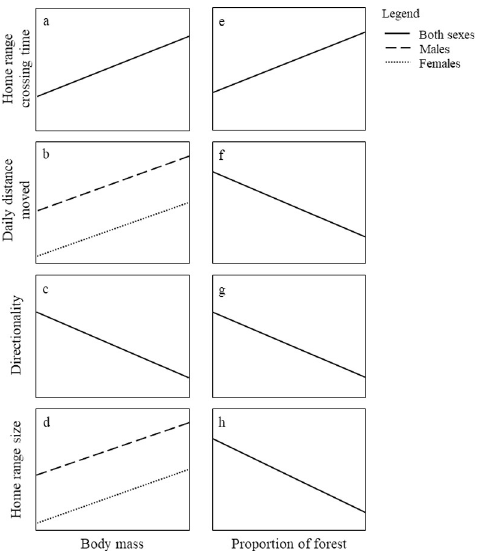
Fig 1. Hypothetical direction and shape of the expected effects of intrinsic (sex and body mass) and environmental traits (proportion of forest cover inside home range) on three descriptors of movement patterns (home range crossing time, daily distance moved and directionality) and home range size of giant anteaters ( Myrmecophaga tridactyla ).